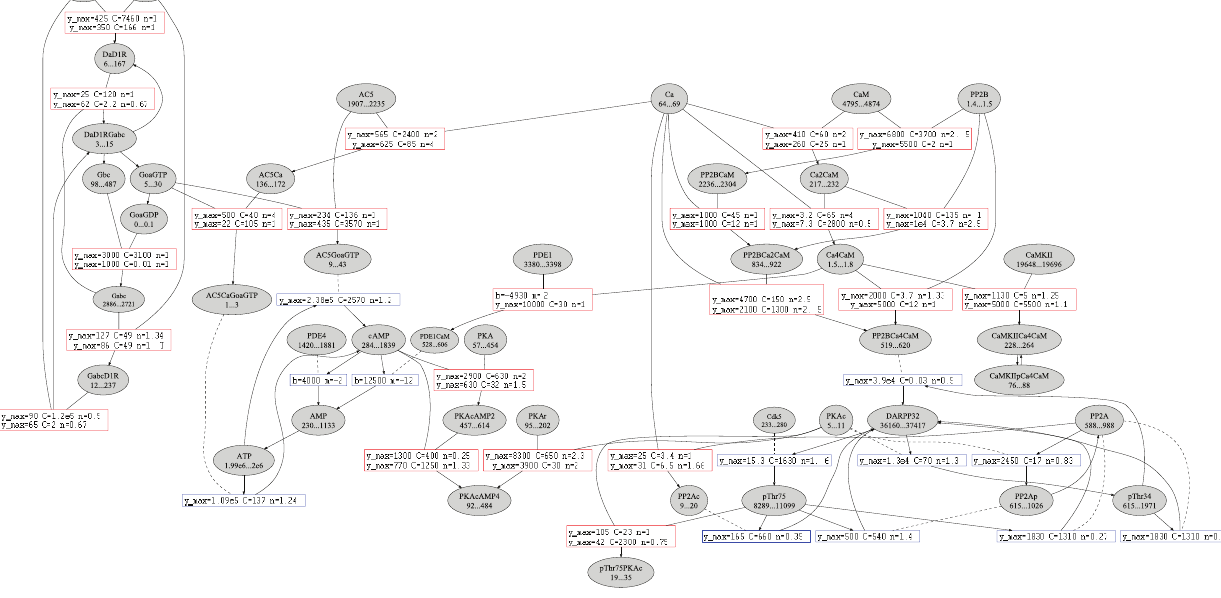
Figure 2. Weighted Dynamic Network View of the Model System. Input conditions are Ca= 8 m M and Da= 60 nM { 5 m M (total available concentration). Each species node is labeled with its steady-state concentration range. Reaction nodes are labeled by parameters for a hyperbolic fit, or a linear fit if that was sufficient. Complex formation reactions (red) are labeled for both ½ A (cid:1) ? ½ AB (cid:1) and ½ B (cid:1) ? ½ AB (cid:1) (left to right), enzymatic reactions (blue) are only labeled for ½ E (cid:1) ? ½ A (cid:2)(cid:1) . The low free concentration for Ca (64–69 nM) is a feature of this model, where Kds are set in such a way that most Ca is bound to calmodulin, and then to other proteins (cAMKII Kinase, PP2B phosphatase and PDE1), such that all ions are indeed accounted for (some species have 2 or 4 Ca ions bound). The present analysis allows to critically evaluate the effect of elementray kinetic parameters on steady-state properties.